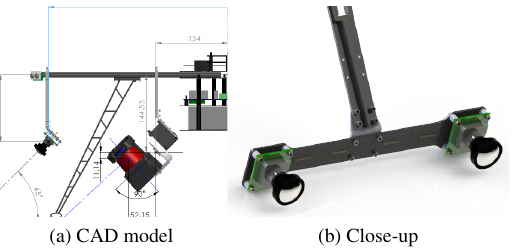
Figure 5: Different height estimates: (a) at low heights the barom- eter is unreliable due to turbulences; (b) at heights above 5m the ultrasonic distance sensor drops out.